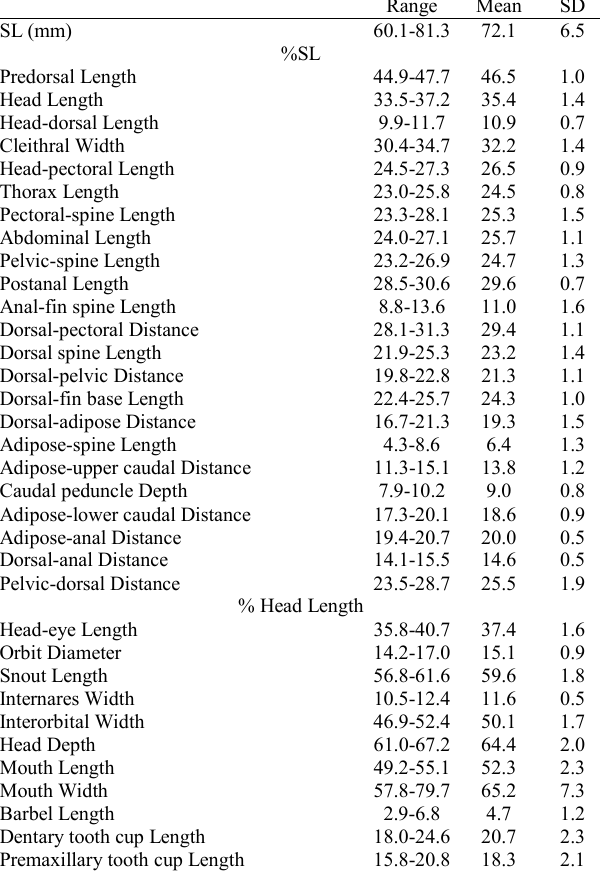
Table 2. Selected morphometric features of Neblinichthys peniculatus (n=8).